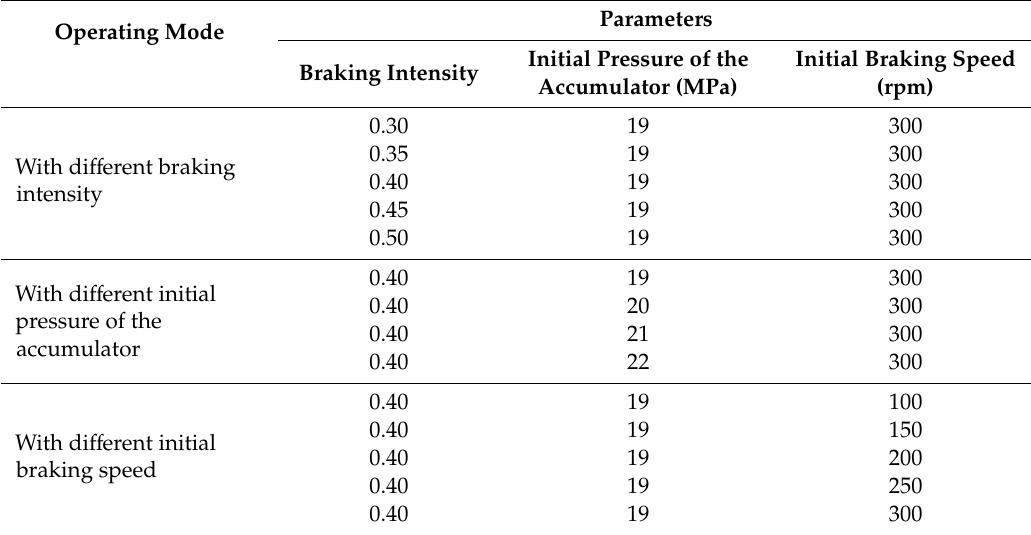
Table 2. The corresponding parameters in the three series of operating modes.